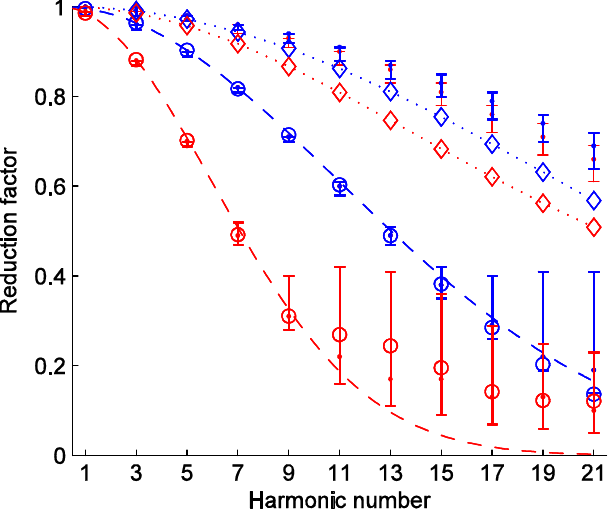
FIG. 15. Reduction factors for peak (circles) and integrated (diamonds) single-electron brightness for the low (blue) and high (red) phase error APS devices, as functions of harmonic number. The dashed lines are Eq. (1), with the appropriate rms phase errors for the two devices. Error bars indicate the range of results expected from a random-walk phase model, using the appropri- for the peak brightness and (cid:1) c for the integrated bright- ate (cid:1) ’ ness calculations from Table I; points give the most probable value of the distribution and error bars show the range that includes 90% of the population (i.e., exclude 5% of the data on either side of the peak).